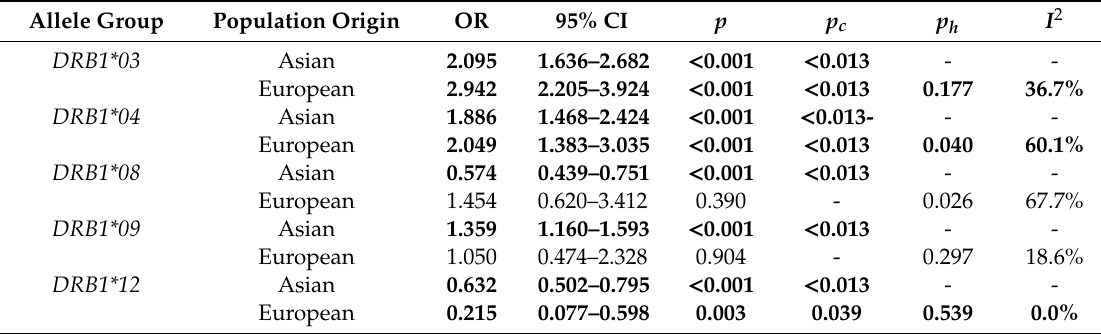
Table 6. Subgroup analysis by population origin for associations of HLA-DRB1 polymorphisms with LADA